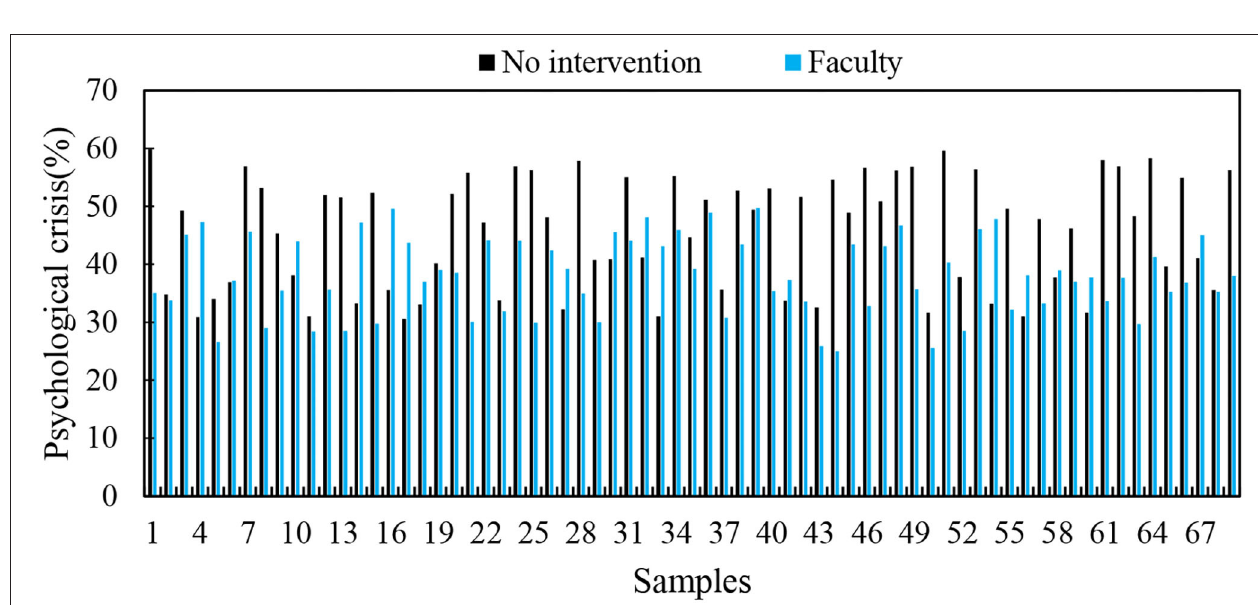
FIGURE 3 | Psychological teacher interviews reduce the degree of a psychological crisis in students.